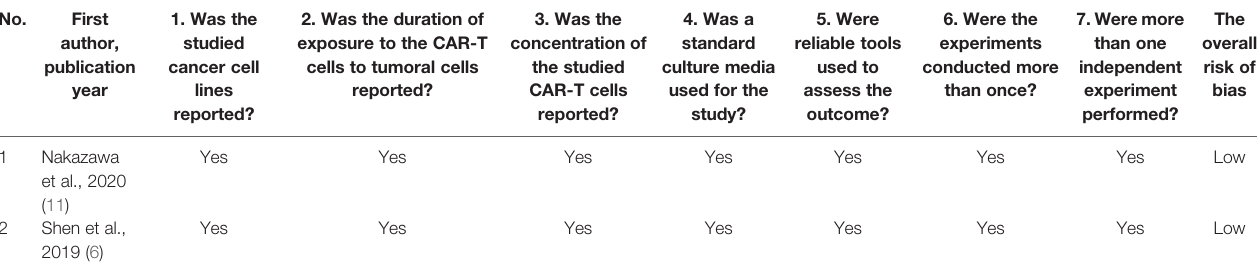
TABLE 3 | Evaluating the potential risk of bias in the included in vitro